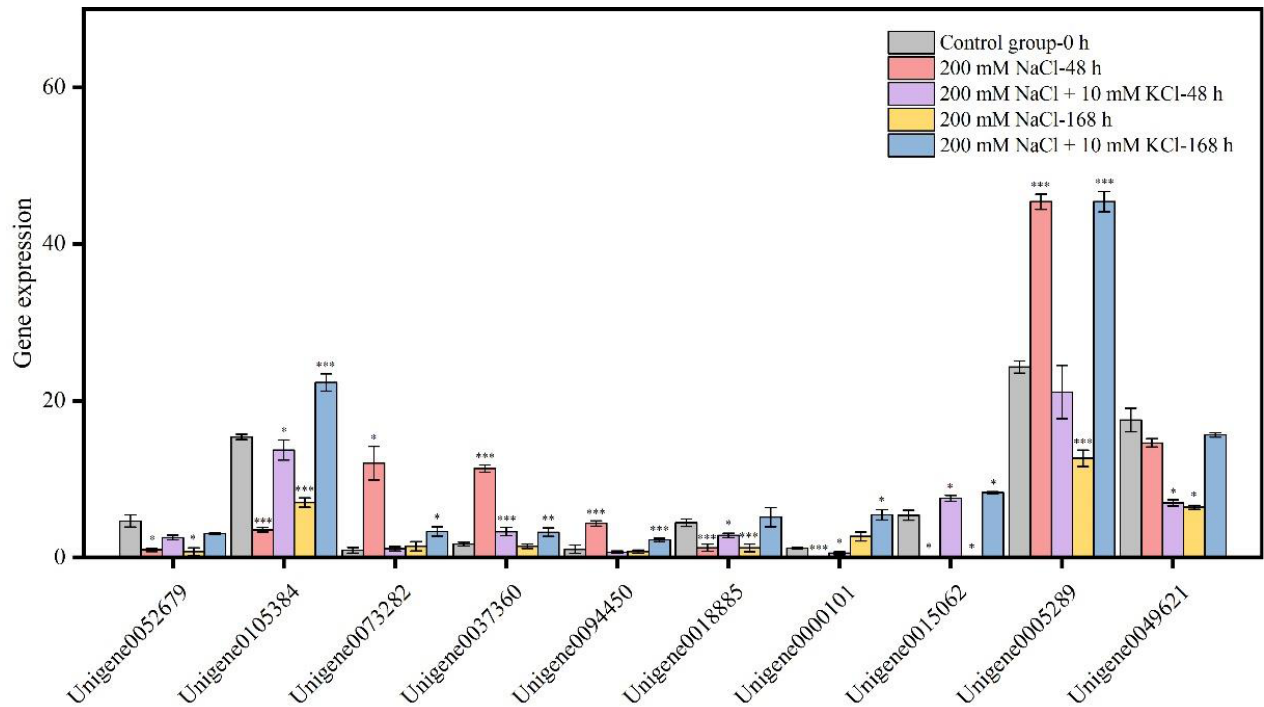
Figure 3. Changes in the expression of key DEGs in the plant hormone signal transduction pathway. (The roots of T. ramosissima were exposed to exogenous potassium for 48 h and 168 h under NaCl stress, and the expression levels of 10 key candidate genes in the Plant hormone signal transduction pathway changed. Note: p ≥ 0.05 is not marked; 0.01 < p < 0.05 is marked as *; 0.001 < p < 0.01 is marked as **; p ≤ 0.001 is marked as *** ).